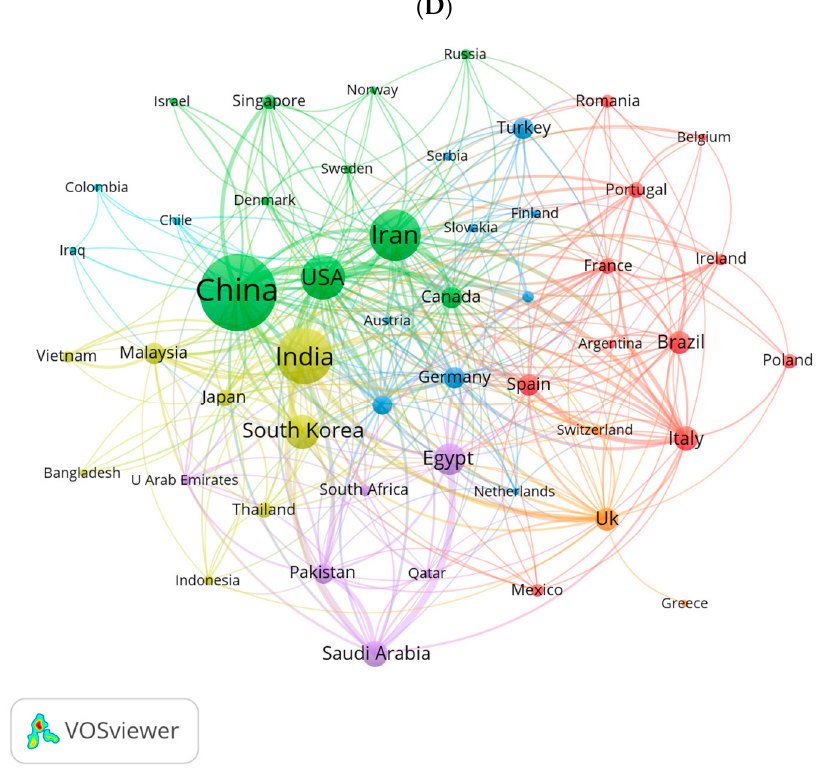
Figure 5. ( A ) The number of publications, total citations ( × 100), average citation per paper, and H-index of the 10 most productive countries/regions. ( B ) The country cooperation network of the top 20 productive countries generated by CiteSpace. ( C ) The international cooperation networks between countries. Line thickness between countries reflects the intensity of the closeness. ( D ) The network map for countries created by the VOS viewer.